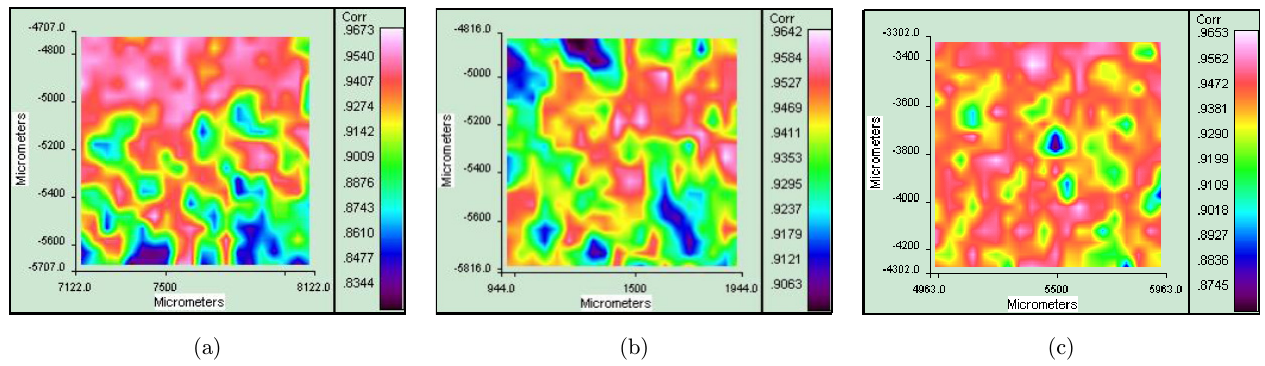
Fig. 1. Detection limits of the method used in nifedipine (a), diclofenac sodium (b) and metformin (c) mixed with betacyclodextrin.